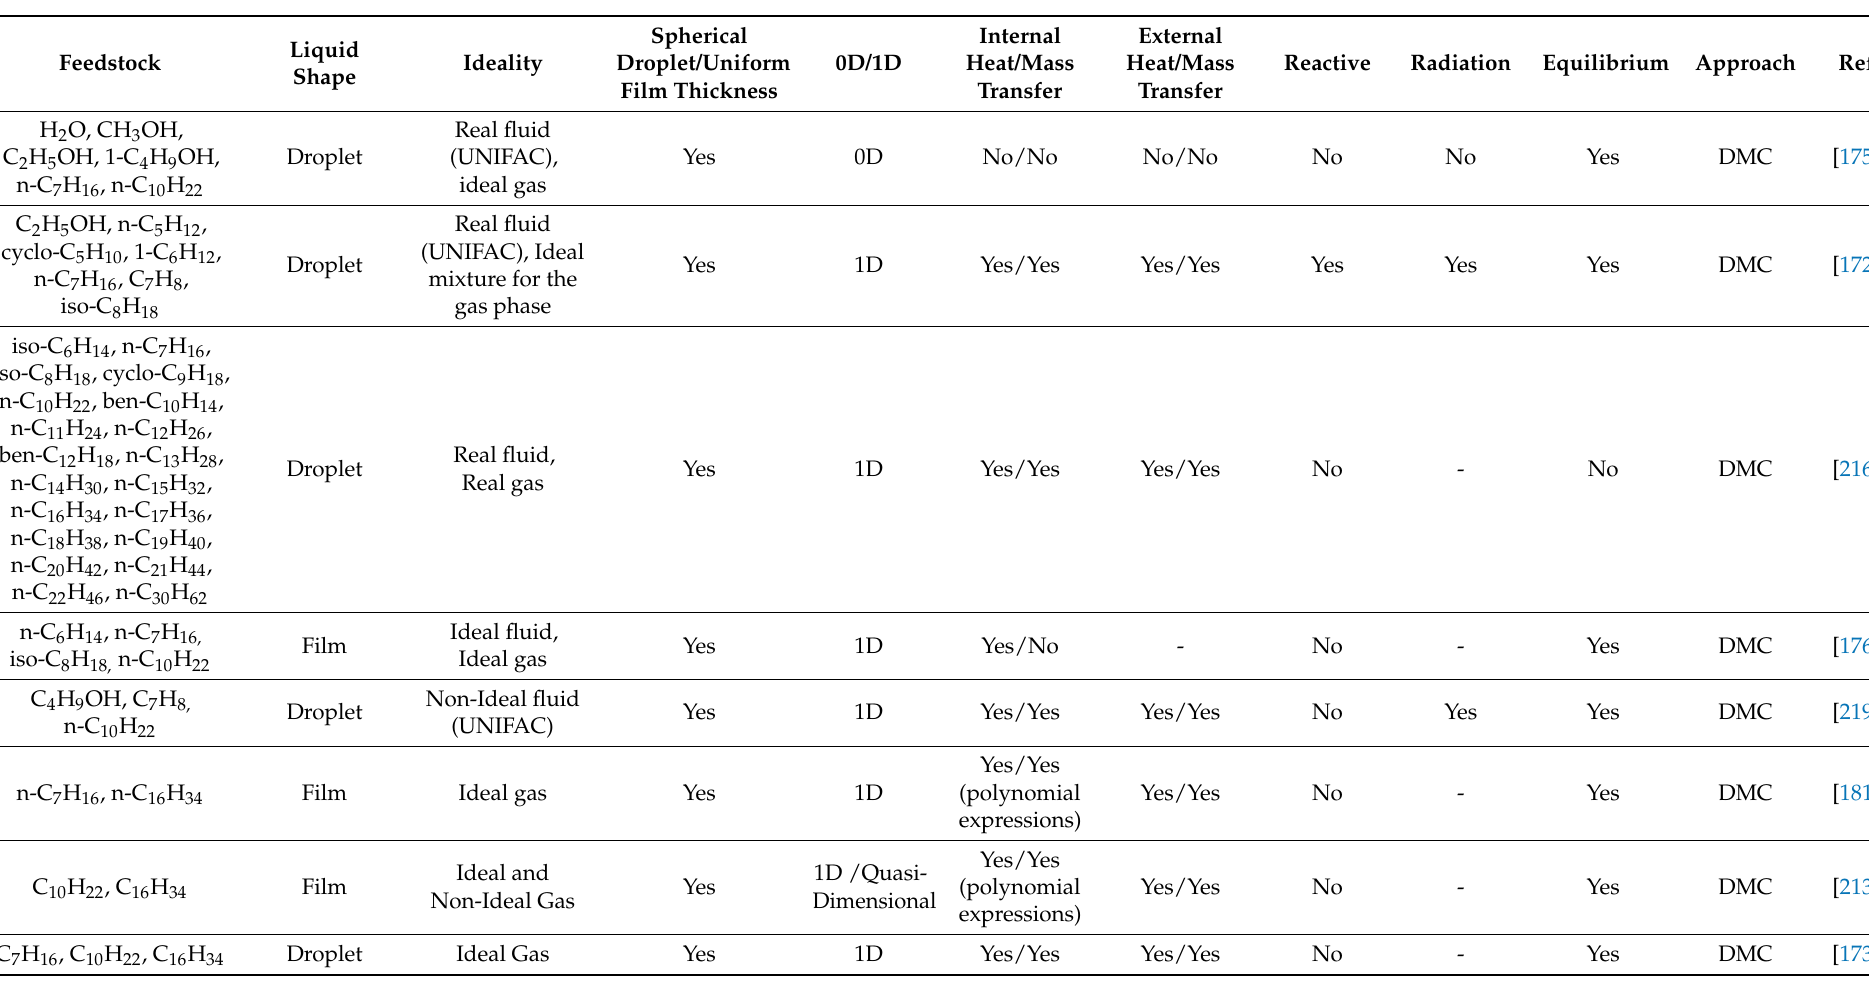
Table 3. Overview of simulation works for evaporation of multi-component